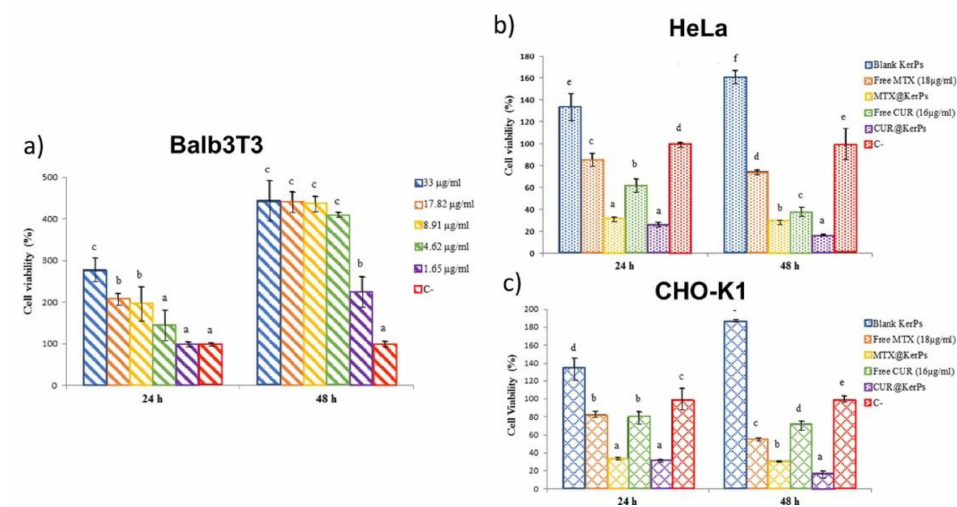
Figure 10. ( a ) Balb3T3 cell viability after incubation with blank KNPs at different concentrations for 24 or 48 h. ( b ) HeLa and ( c ) CHO-K1 cells viability when exposed to blank and drug-loaded KNPs (33 µ g/mL) after 24 and 48 h. Adapted with permission from [62]. Copyright 2021 American Chemical